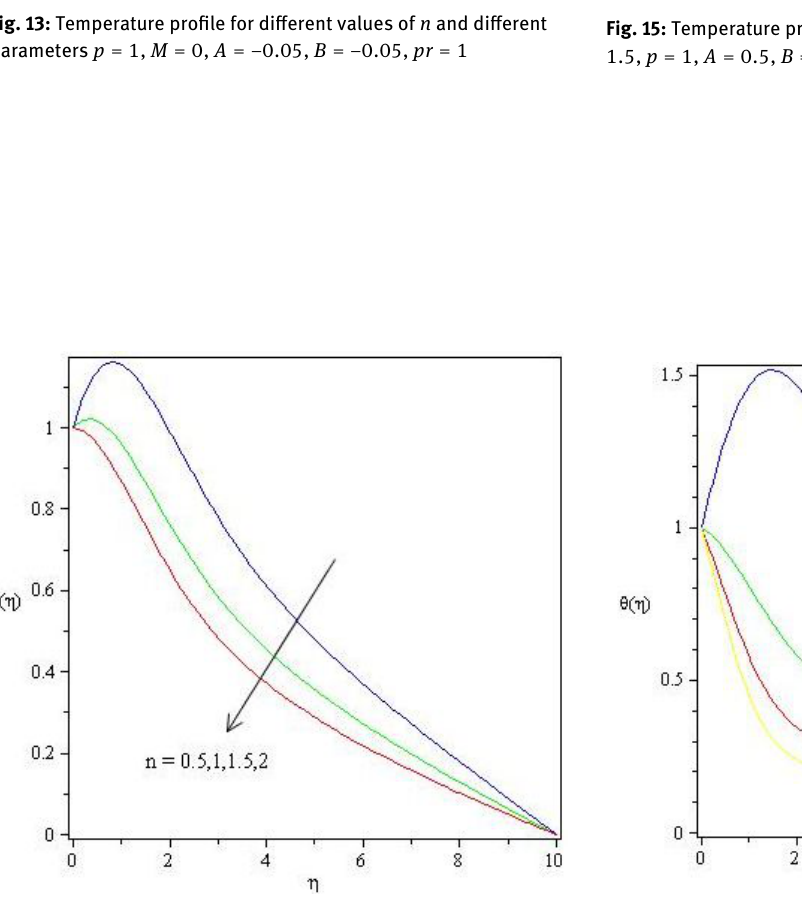
Fig. 14: Temperature profile for different values of n and different parameters p = 1, pr = 1, M = 0.5, A = 0.5, B = 0.5